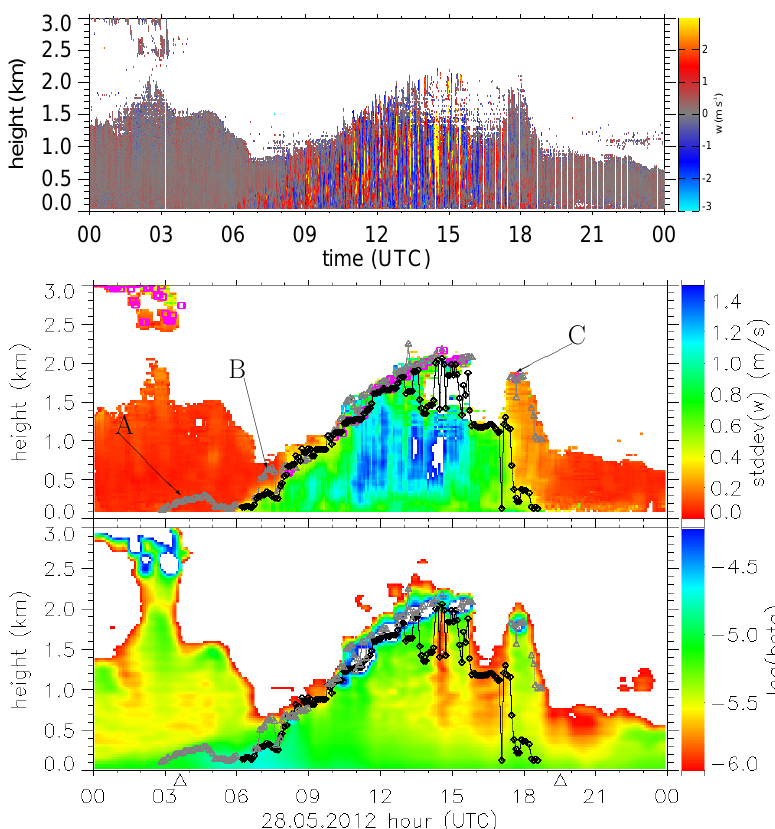
Figure 4. Time–height sections of vertical velocity (top), its standard deviation (stddev, mid panel) and aerosol backscatter coefficient (beta, bottom panel) on 28 May 2012. MLH retrieved from wind lidar (solid black with diamonds) and from ceilometer (solid grey with triangles). Magenta squares indicate cloud base heights as determined by the ceilometer. Triangles at the abscissa mark sunrise and sunset. Letters A, B and C refer to descriptions in the text. Temporal resolution of the vertical velocity plot is 1